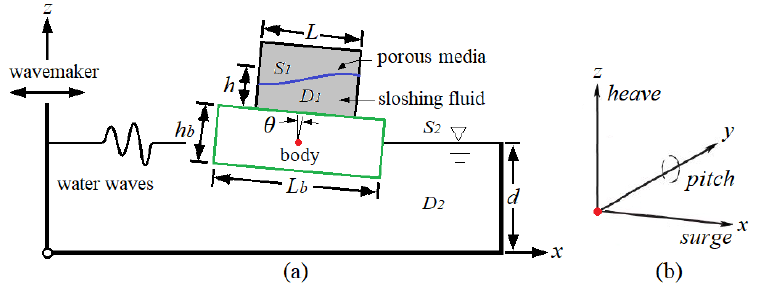
Figure 1. ( a ) Configuration of a floating body undergoing wave excitations with a water tank, installed with porous media, attached above; ( b ) degree of freedom of the floating body motion.